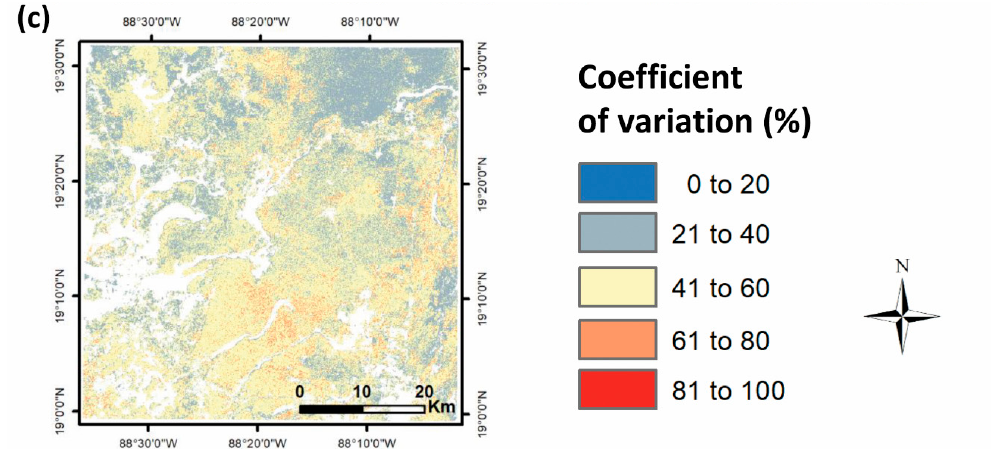
Figure 7. Deciduousness uncertainty maps for each vegetation type: ( a ) deciduous (El Palmar), ( b ) semi-deciduous (Kaxil Kiuic), and ( c ) semi-evergreen (Felipe Carrillo Puerto: FCP).